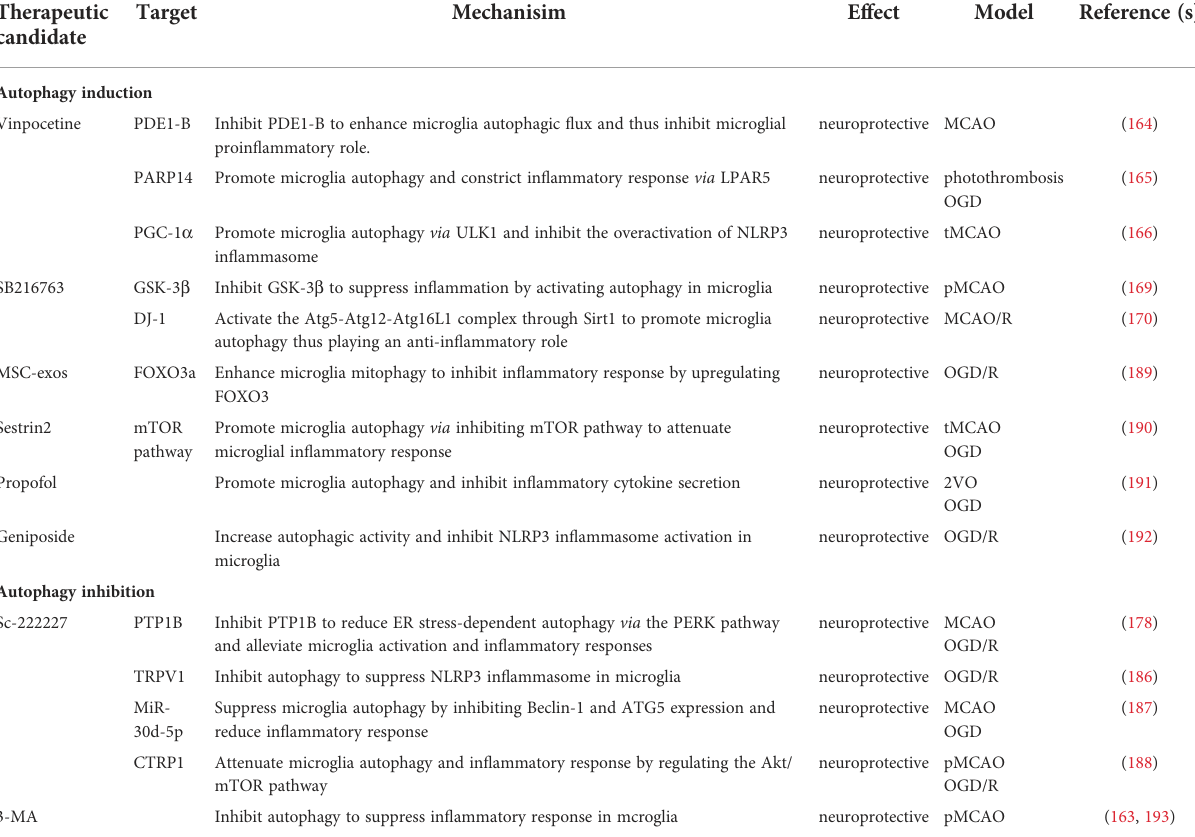
TABLE 1 Mechanisms and effects of microglia autophagy regulators in the regulation of in fl ammatory responses in IS. Therapeutic